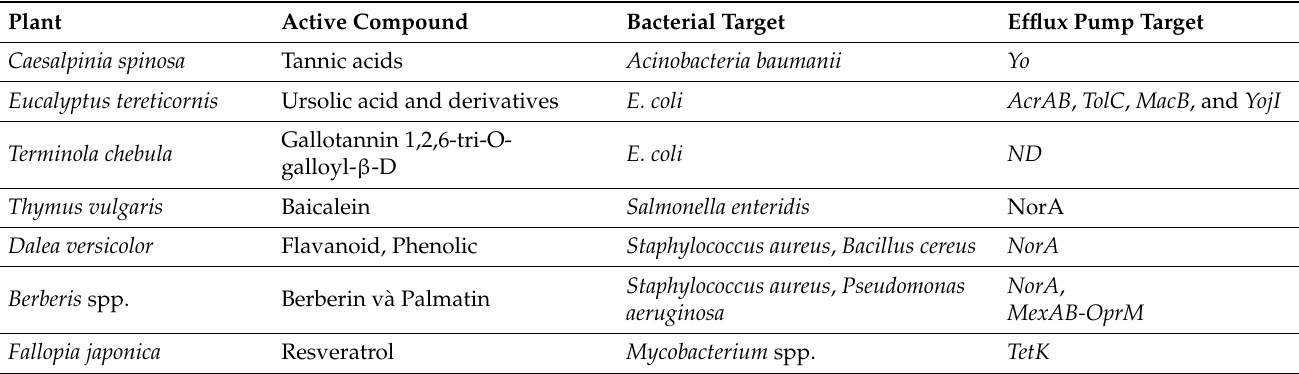
Table 3. EPIs originating from plants, their target, and the bacterial pathogens inhibited